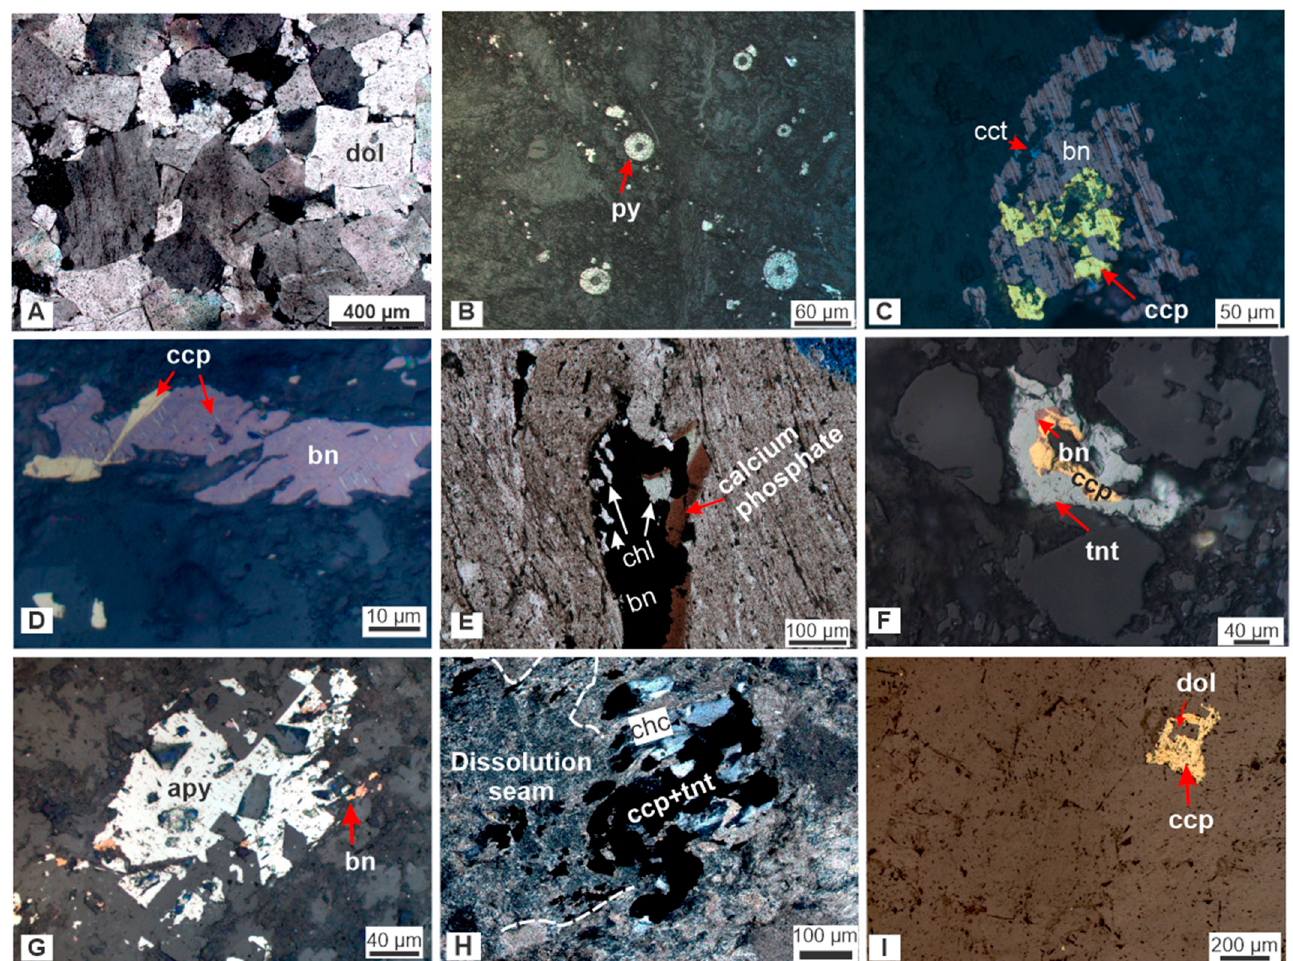
Figure 5. Photomicrographs illustrating the main sulfides and sulfosalts and their relationship with other minerals. ( A ) Euhedral to subhedral dolomite. ( B ) Pyrite (py) replacing bioclasts. ( C ) Chalcocite (cct), bornite (bn), and chalcopyrite (ccp) clustered. ( D ) Lamellae of chalcopyrite within bornite. ( E ) Bornite with inclusions of chlorite (chl) and calcium phosphate ( F ) Tennantite (tnt) overprinting chalcopyrite and bornite. ( G ) Arsenopyrite (apy) overprinting bornite. ( H ) Chalcopyrite and tennantite with chalcedony (chc) hosted in dissolution seam. ( I ) Chalcopyrite encircling dolomite (dol).